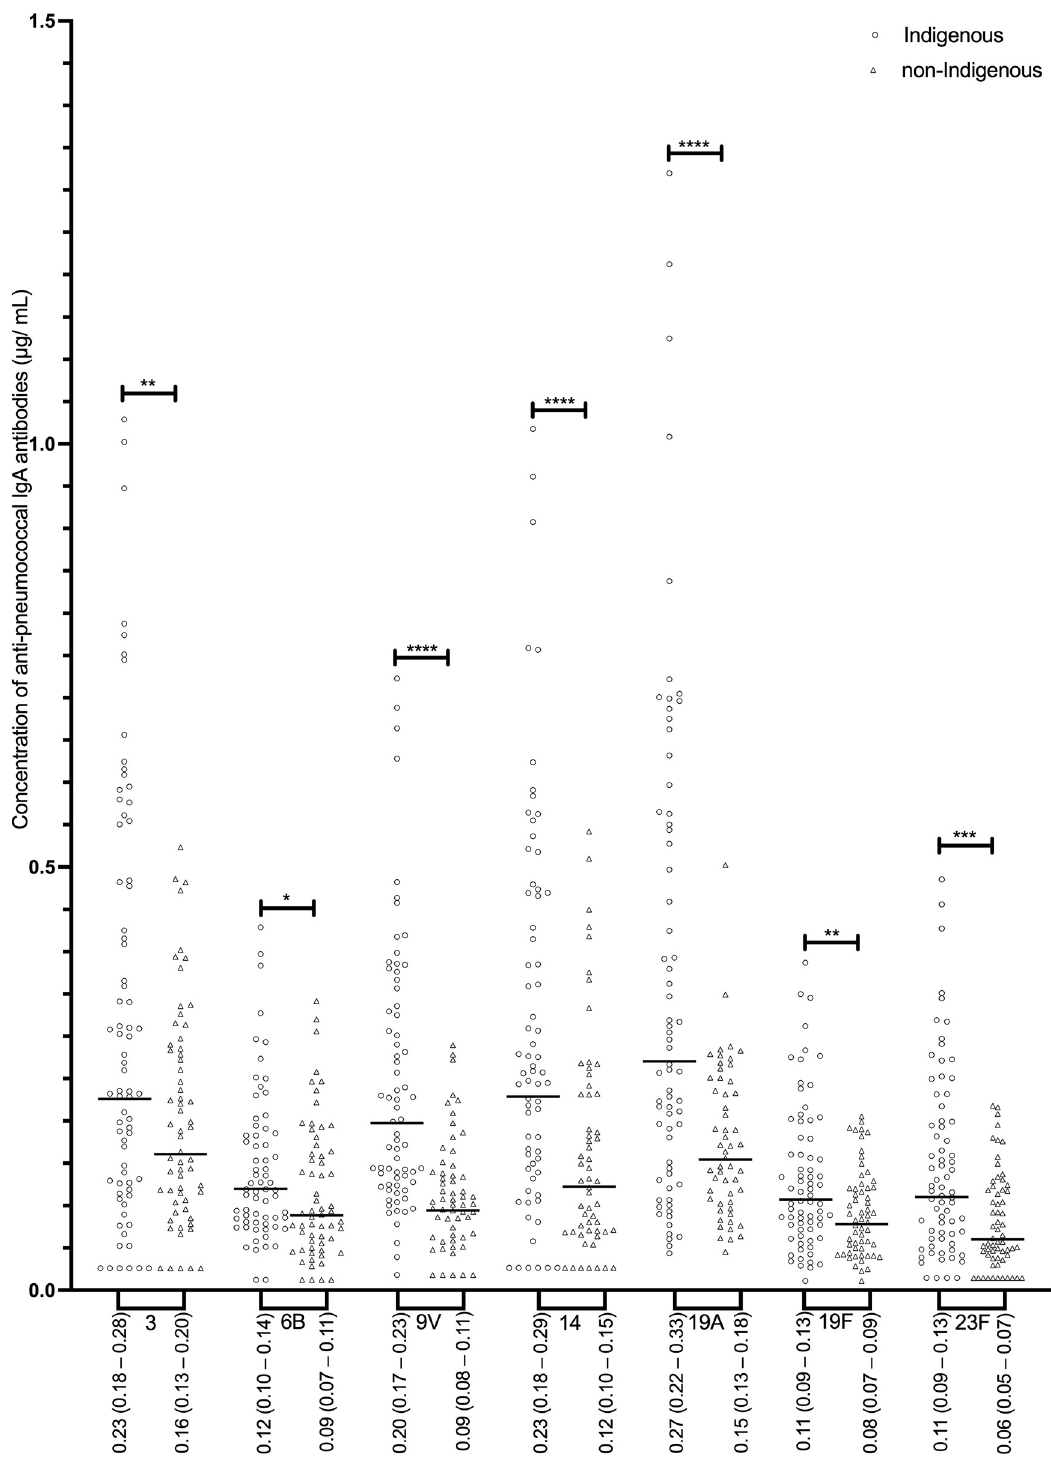
Fig 3. Concentrations of serotype-specific pneumococcal IgA antibodies for Indigenous (n = 77) and non-Indigenous groups (n = 64). Geometric mean antibody concentrations are displayed ( μ g/ mL) and the 95% confidence intervals of the GMC. Statistical significance was determined using a Mann-Whitney U test for all serotypes. � p < 0.05, �� p < 0.01, ��� p < 0.001, ���� p < 0.0001.